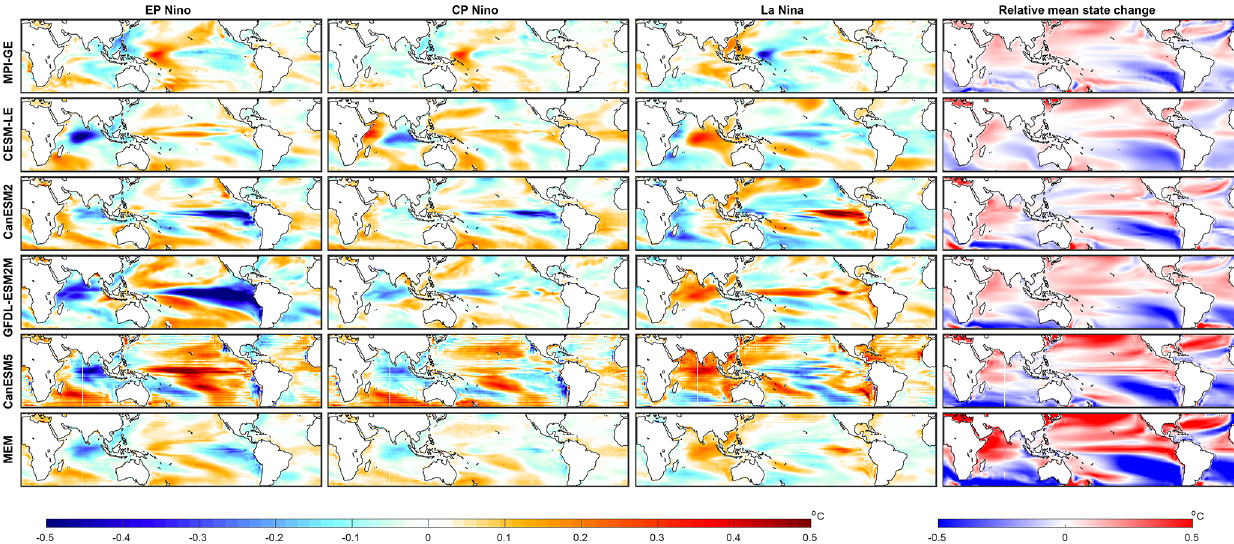
Figure 5. Change in SST pattern in each SMILE in the period 2050–2099 as compared to 1950–1999 for EP and CP El Niño events and for La Niña events (left, centre left, and centre right columns respectively. The mean state change in SST is shown in the right column; shown for each individual SMILE (in order of appearance: MPI-GE, CESM-LE, CanESM2, GFDL-ESM2M, CanESM5) and the multi-ensemble mean (bottom row). The SST pattern is calculated as the November, December, January average and composited for each event type over each time period. The relative mean state change is calculated as the ensemble mean SST over each time period, with the earlier period subtracted from the latter relative to the total change in the region shown (0–360 ◦ E, 40 ◦ S–40 ◦ N). SMILE data have the forced response (ensemble mean) removed prior to calculation for the SST change, but not the mean state